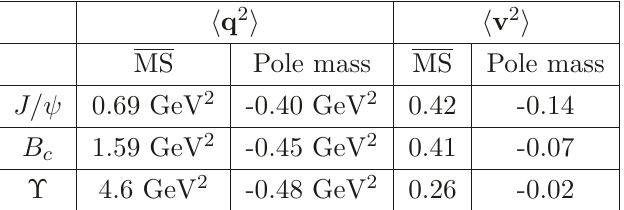
Table 1 . Values of Meson mass Quark mass α s J/ψ